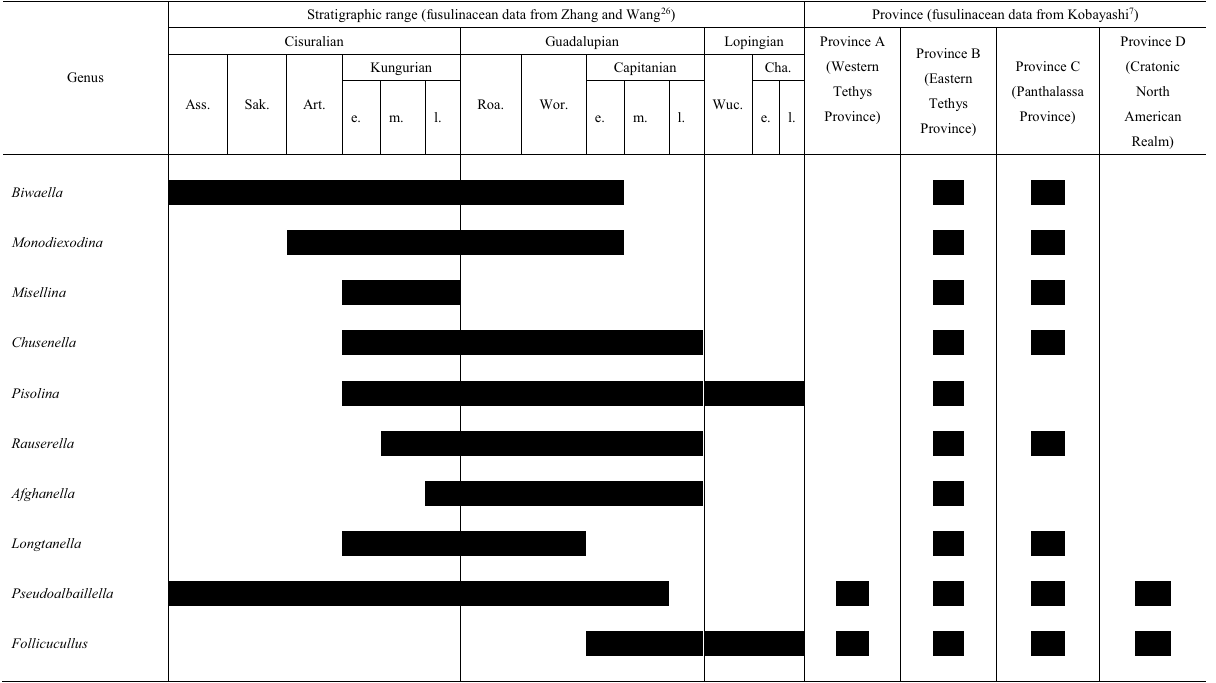
Table 1. The stratigraphic range and province of the selected fusulinacean and radiolarian